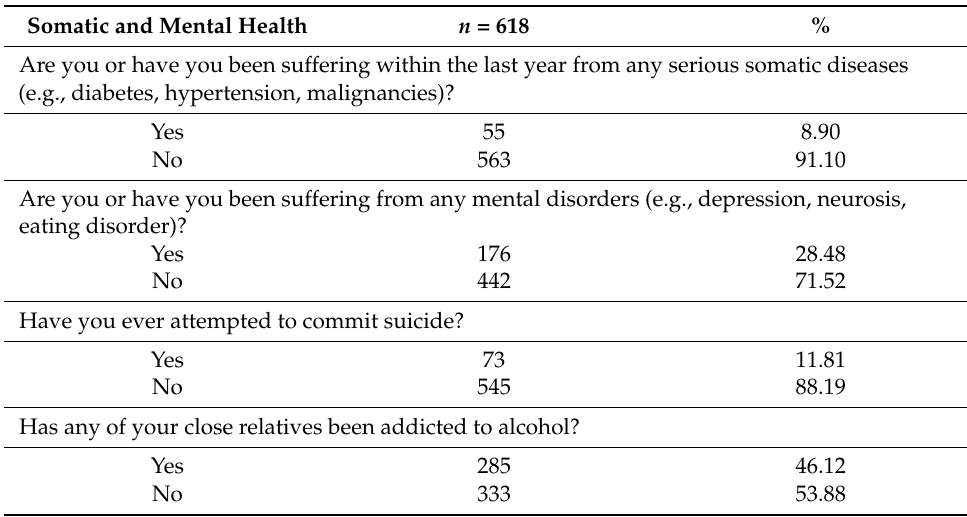
Table 4. Somatic and mental health of the